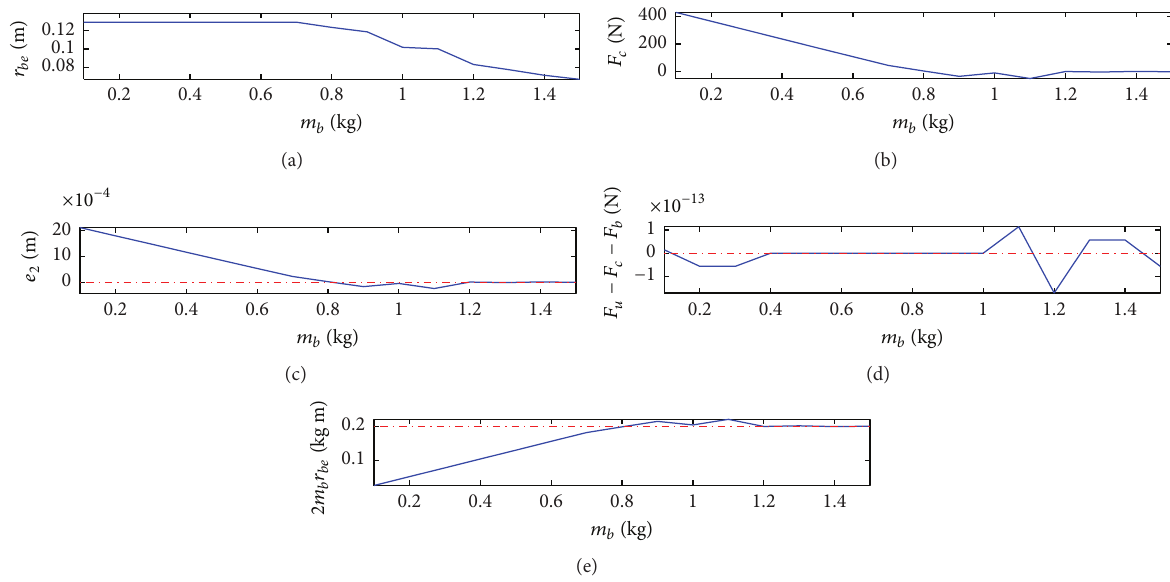
Figure 9: Variations of 𝑟 𝑏𝑒 , 𝐹 𝑐 , 𝑒 2 , 𝐹 𝑢 − 𝐹 𝑐 − 𝐹 𝑏 , and 2𝑚 𝑏 𝑟 𝑏𝑒 along with the increase of 𝑚 𝑏 when Ω = 8 Hz and ℎ 𝑐 = 0.03 m.